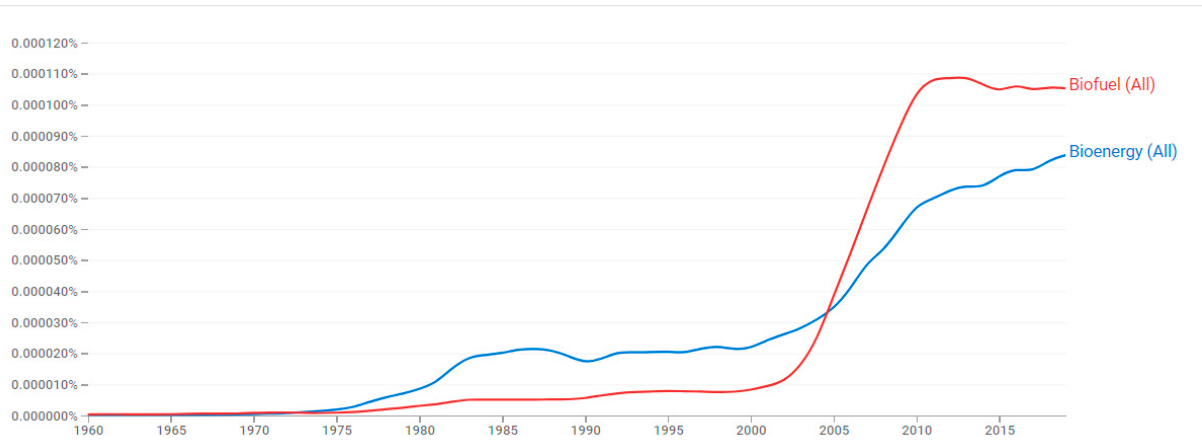
Figure 4. Google Books Ngram Viewer analysis results on the requests “bioenergy”, “biofuel”.